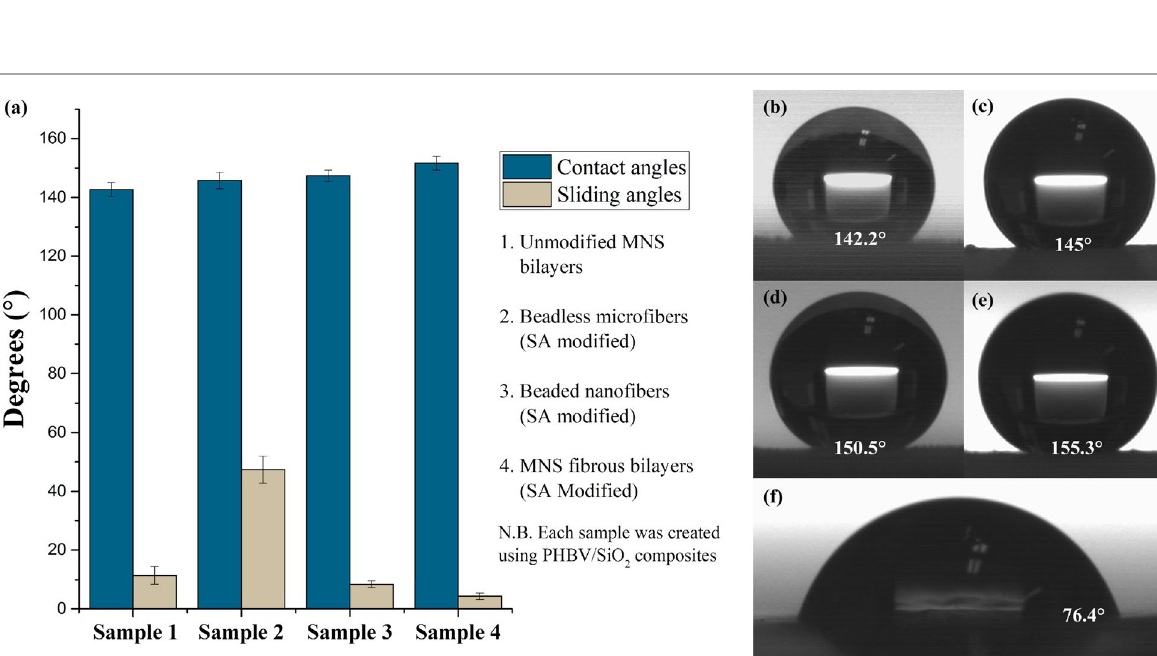
Fig. 9 a Comparison of the WCAs and sliding angle of a 4 μL water droplet for four different sample designs; b micro-nanofibrous (MNS) bilayers before SA treatment; c SA modified beadless microfibers; d SA modified beaded nanofibers e SA modified MNS bilayers f PHBV/SiO 2 film cast on a glass